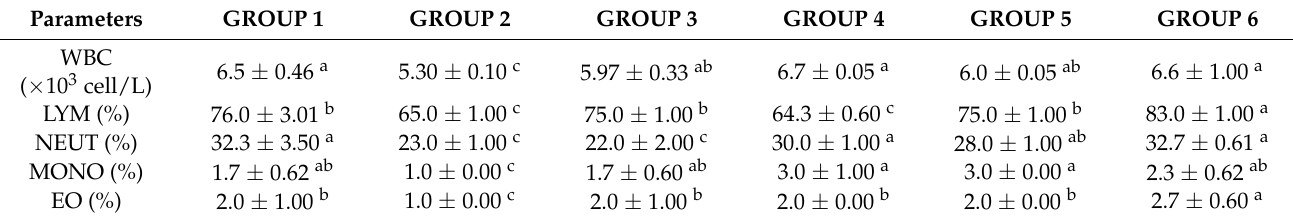
Values are expressed as mean ± S.D, ( n = 3). Mean with similar superscript on the same column are not significantly difference ( p < 0.05). WBC: white blood cell, LYM: lymphocytes, NEUT: neutrophils, MONO: monocytes, EO: eosinophils. Group 1: normal control, Group 2: venom control, Group 3: envenomed rats treated with 0.2 mL of polyvalent antivenom, Group 4: envenomed rats treated with 200 mg/kg − 1 of the extract, Group 5: envenomed rats treated with 400 mg/kg − 1 of the extract, Group 6: envenomed rats treated with 600 mg/kg − 1 of the extract.